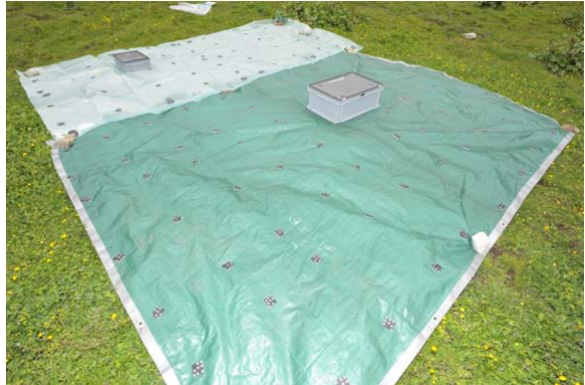
Figure 13: An In-Field Calibration Field with Australis Retro- Reflective Calibration Targets